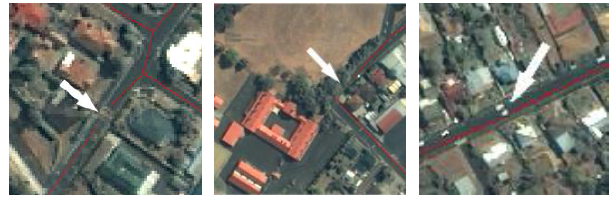
Figure 5. Some small gaps in the extracted road